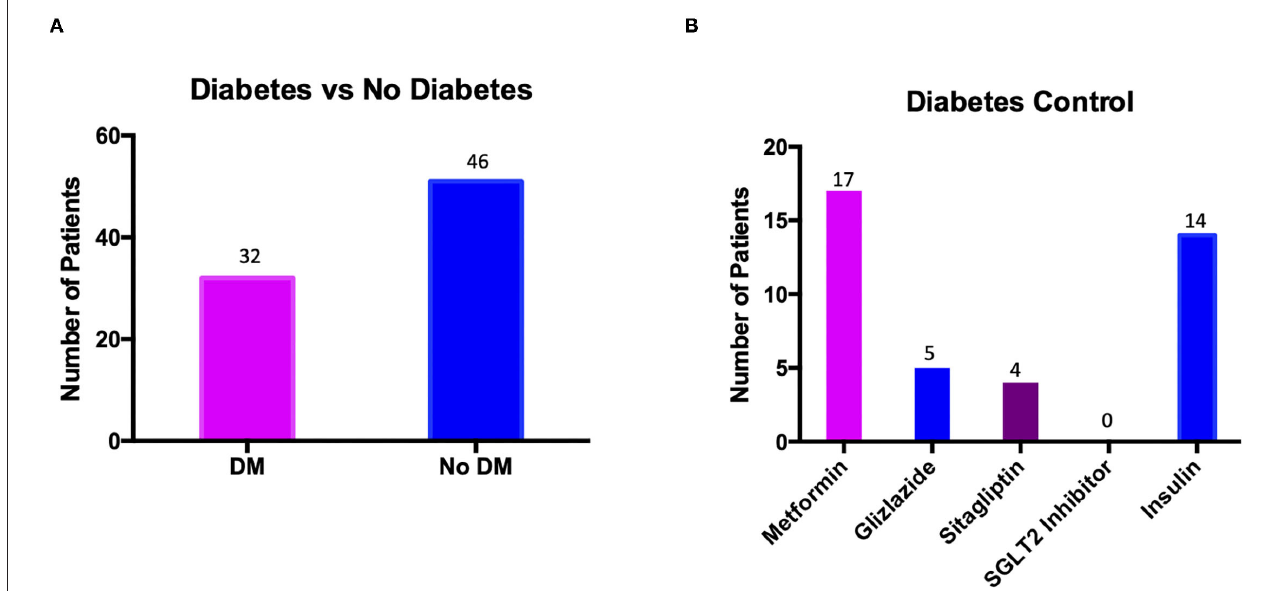
FIGURE 1 | Graphs to show (A) the number of patients presenting with Fournier’s Gangrene who had diabetes mellitus (DM) against the number who did not (No DM); (B) the number of patients with diabetes mellitus taking each individual medication.